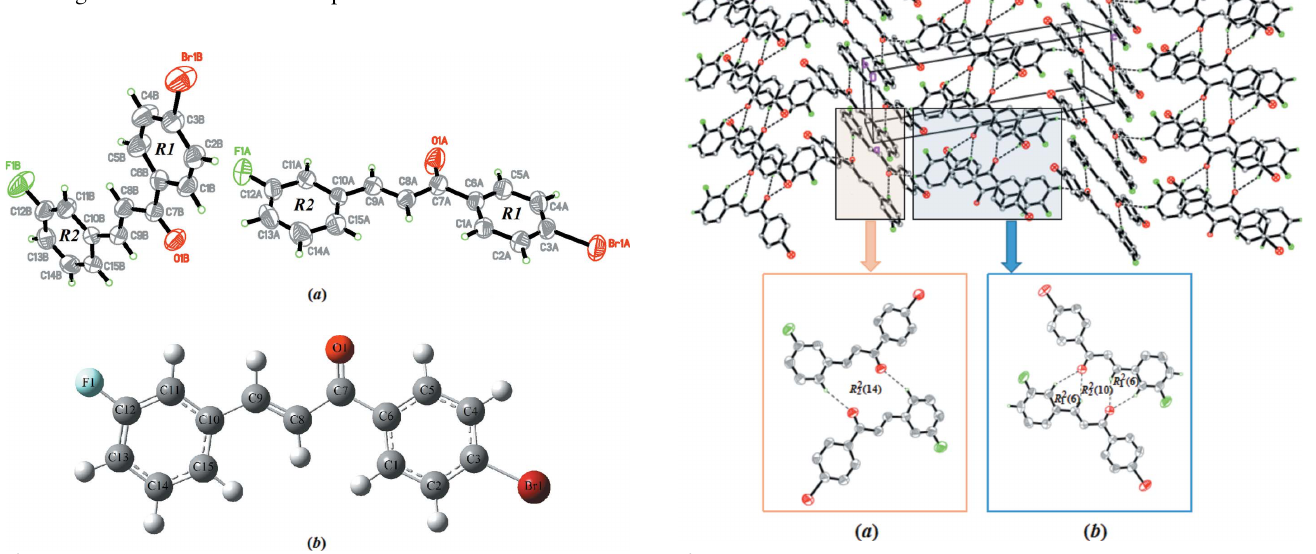
(14) ring motifs and ( b ) 2